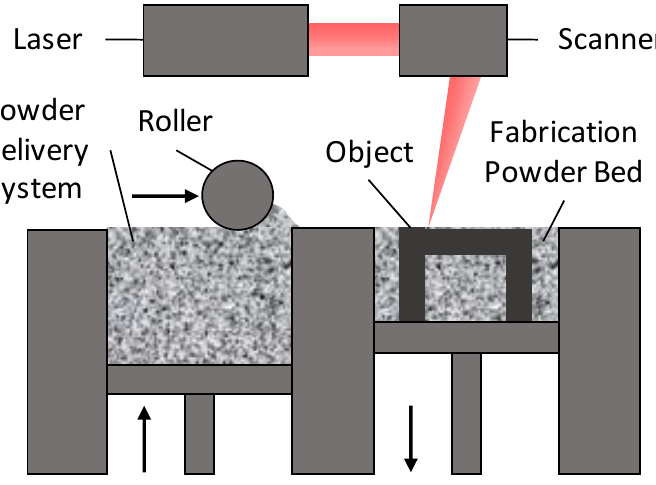
Figure 5. Schematic used generally to represent the direct metal laser sintering (DMLS) technique.